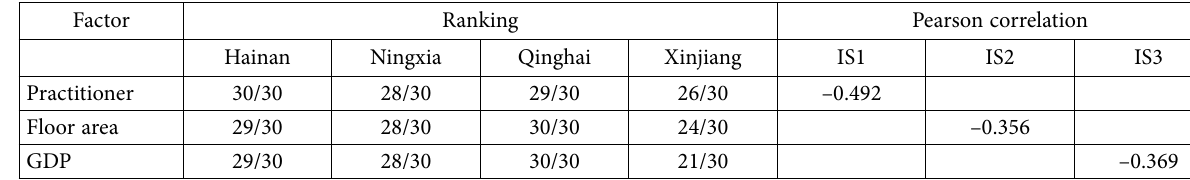
Table 7. Characteristics of Cluster 1